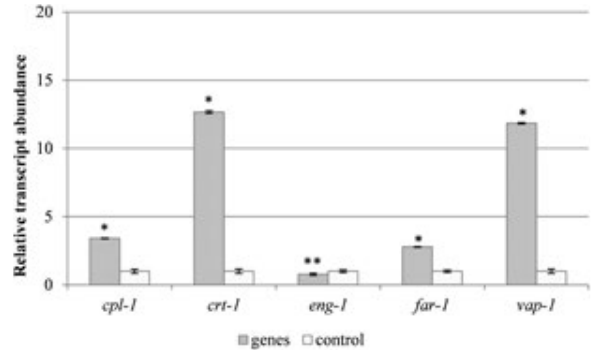
Figure 1. Relative transcript abundance of Meloidogyne his- panica cpl-1 , crt-1 , eng-1 , far-1 and vap-1 genes determined by qRT-PCR after exposure of second-stage juveniles to to - mato cv. Easypeel root exudates. Values are means of three replicates, and bars represent standard deviation. Signifi - cant differences (* P <0.05 and ** P =0.05) were assessed by iteration test (REST 2009